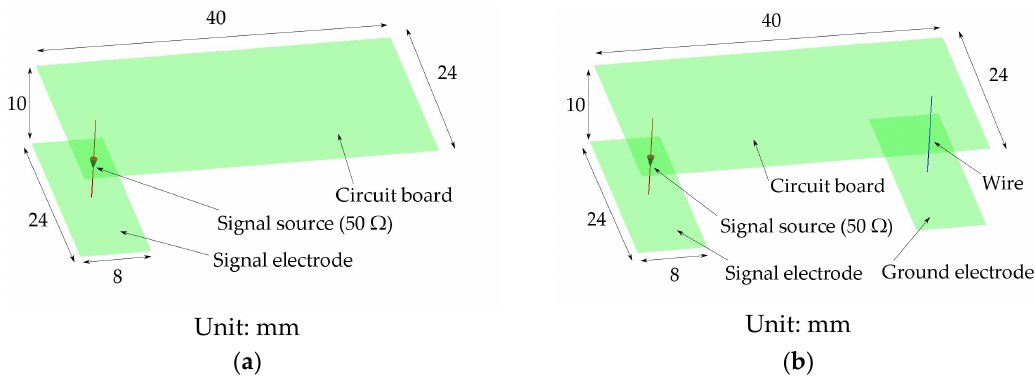
Figure 3. Transmitter models: ( a ) One-electrode transmitter; ( b ) Two-electrode transmitter.